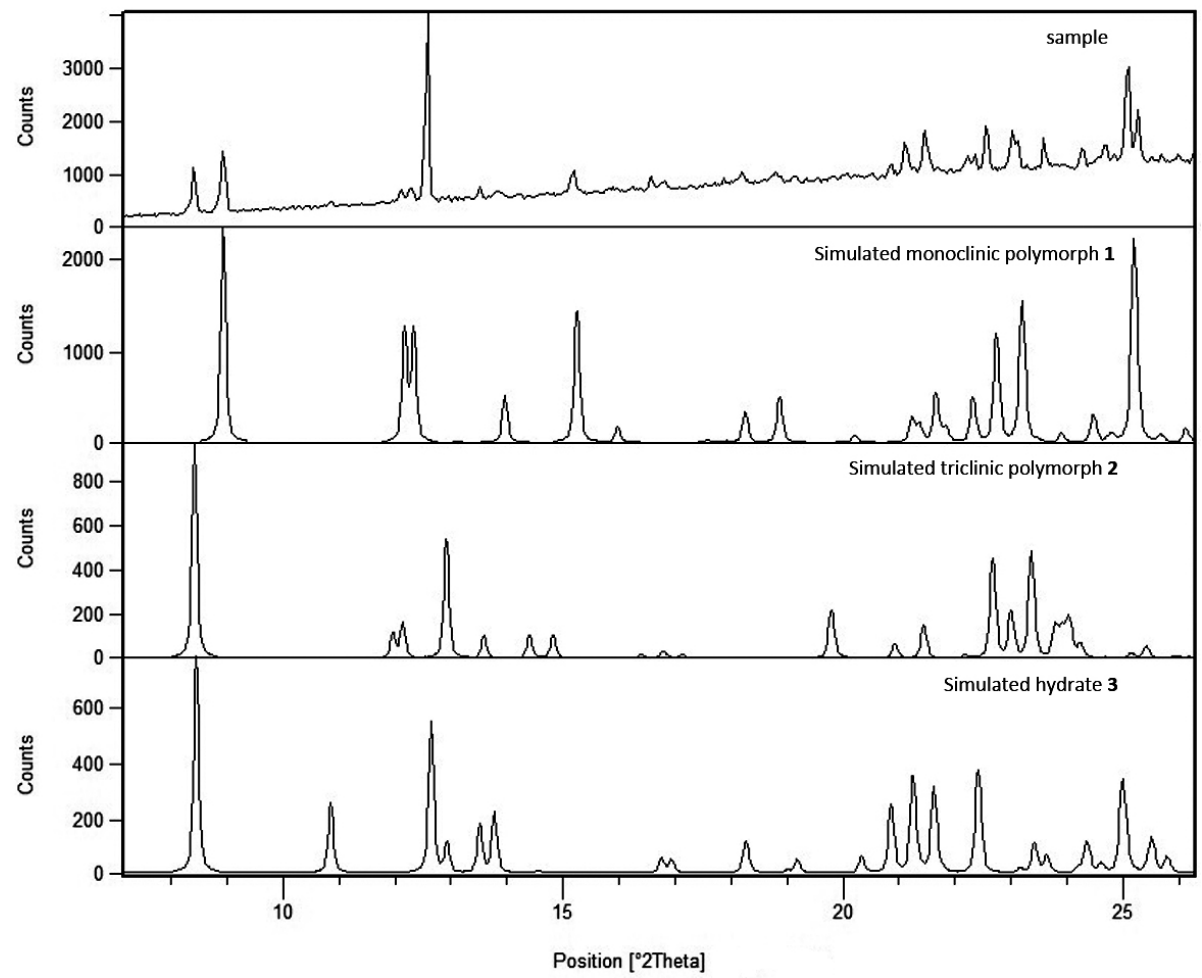
Figure 1. Comparison of the measured powder diffraction pattern of the reaction product and the simulated diffraction patterns of the two poly- morphs and the